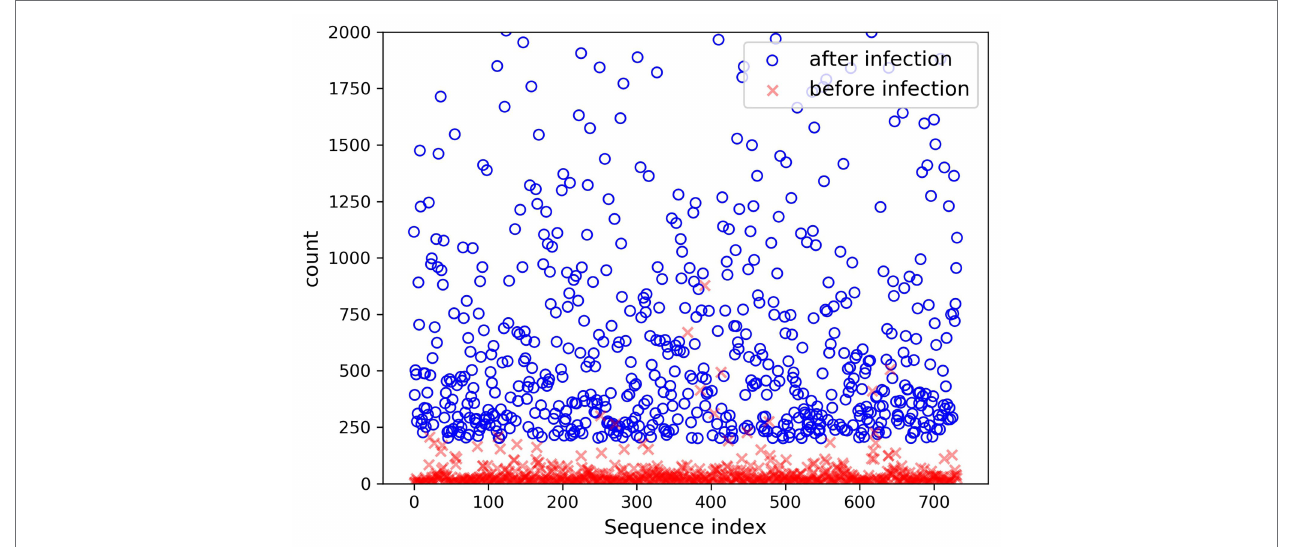
FIGURE 6 | Changes in expression level (upper limit 2,000) before and after